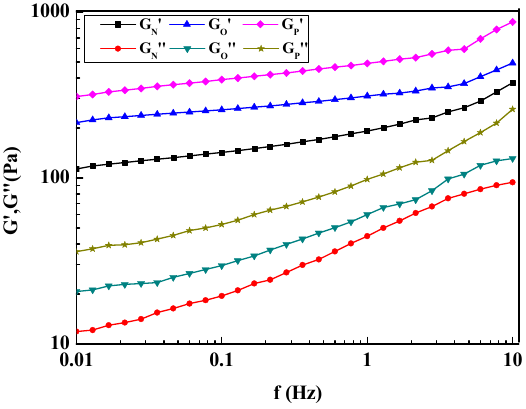
Figure 1. Viscous moduli (G ″ ) and elastic moduli (G) of hydrogels: normal hydrogel (G N ), hydrogel containing ordinary microspheres (G O ), and hydrogel containing polymerizable microspheres (G P ).